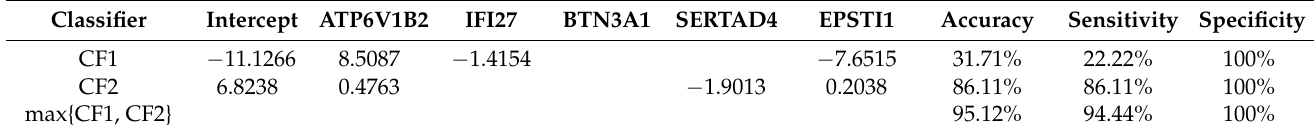
Table 14. GSE166530: Characteristics of the top-performing five-gene classifier. CF1 and CF2 are the first and second individual classifiers for data of COVID-19 patients vs. healthy controls.